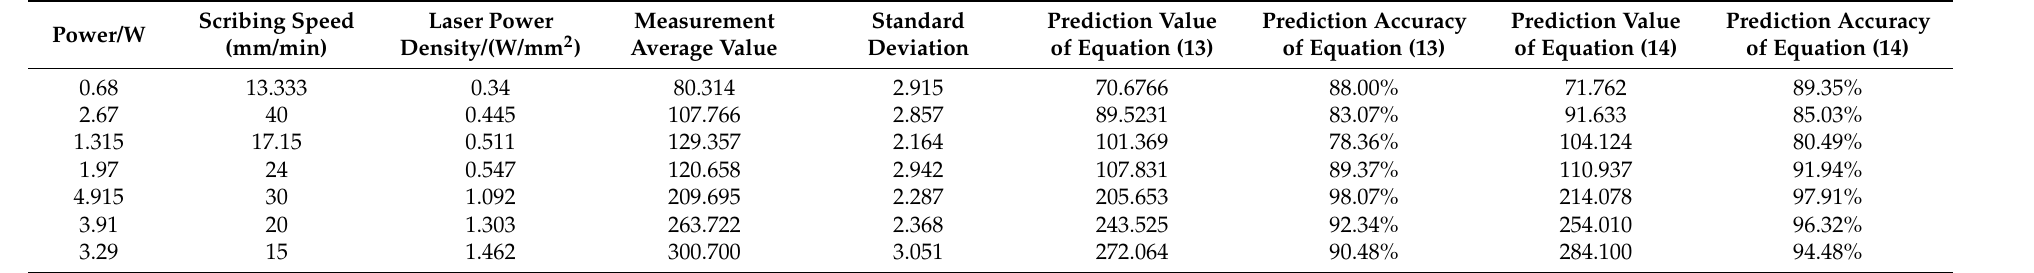
Table 5. Prediction results of testing set